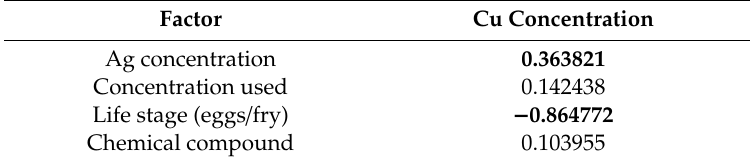
Table 7. Spearman correlation results. The statistically significant correlations are marked in bold ( p < 0.05).